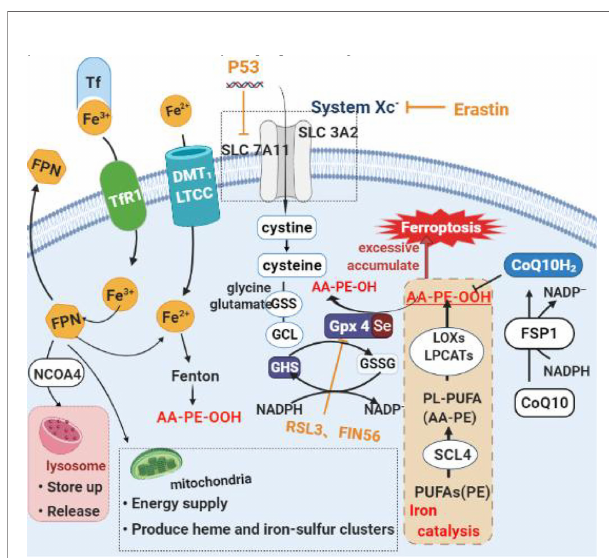
FIGURE 2 | Diagram of the main mechanism of Ferroptosis. (A) Lipid peroxide restoration mechanism mainly based on Erastin/Glutathione/Gpx4 axis. Erastin, an iron death inducer, inhibits cystine uptake and subsequent glutathione biosynthesis by inhibiting System Xc-. This reduces the activity of GPX4, accumulates a large amount of lipid oxides, and eventually causes ferroptosis. (B) Intracellular free long-chain polyunsaturated fatty acids can undergo acylation lipidation oxidation under the sequential action of ACSL4, LOXs and LPCAT3 to generate lipid peroxidation. Ferroptosis occurs when its level exceeds a threshold. At the same time, iron ions promote the process. (C) Normally most of the iron in the matrix is taken up by mitochondria to synthesize heme and iron-sulfur clusters, and a few are reserved in FPN. Ferroptosis is often accompanied by increased transferrin content. This makes a large amount of FPN binded with NCOA4 be transported to lysosome to degrade and release iron, which ultimately leads to the destruction of iron homeostasis, the increase of local iron content and the occurrence of